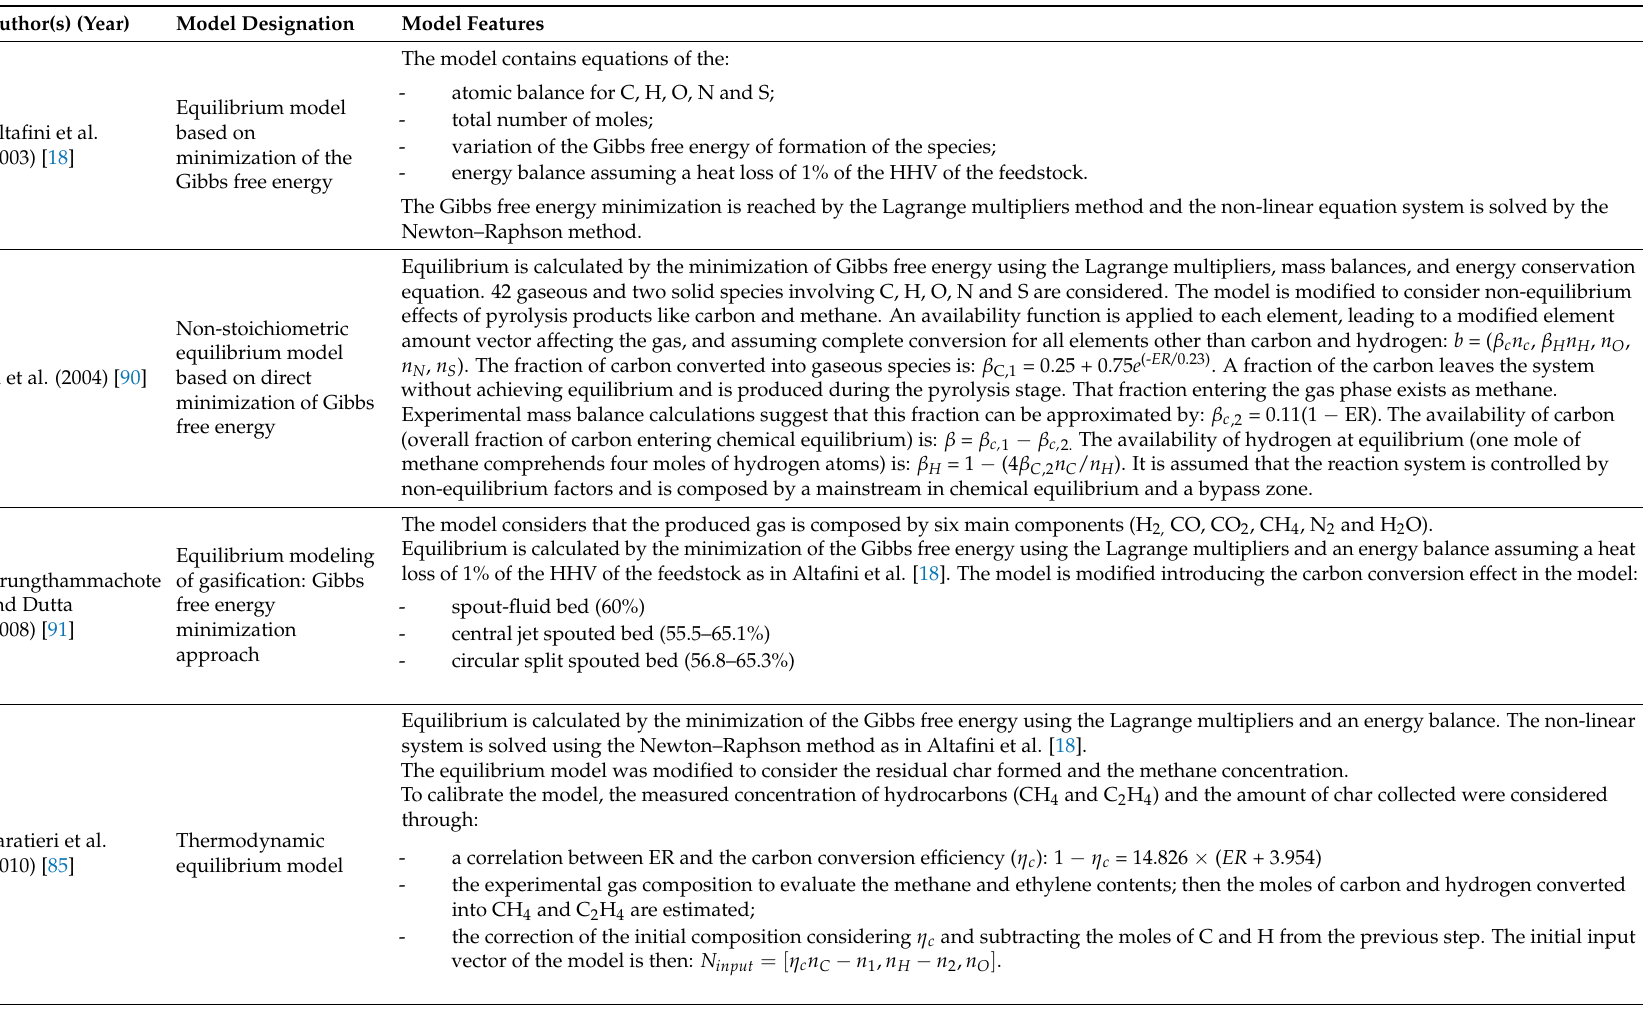
Table 4. Non-stoichiometric equilibrium